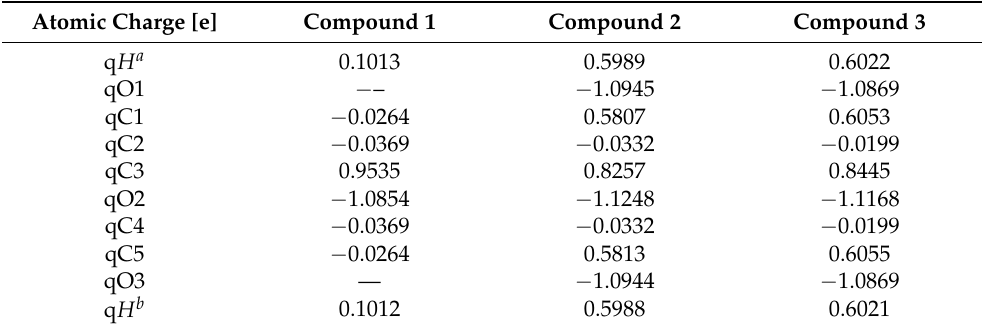
Table 1. Atomic charges values computed based on Atoms in Molecules (AIM) theory at the B3LYP/6- 311+G(d) level of theory in